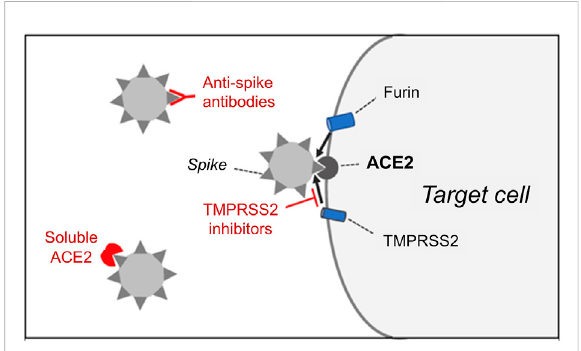
FIGURE 1 The entry of SARS-CoV-2 into target cells requires the binding of the spike protein present on the surface of the virus to cell membrane-bound angiotensin-converting enzyme 2 (ACE2), which acts as a receptor for the virus. Spike protein cleavage by the host cell proteases, transmembrane protease serine 2 (TMPRSS2) and furin, is also required for the fusion of the viral membranewiththeplasmamembraneofthecell.Ongoingclinical trials aim to determine whether cell entry of the virus can be prevented by1)anti-spikeantibodies,2)soluble ACE2 extracellular domain or 3) inhibitors of